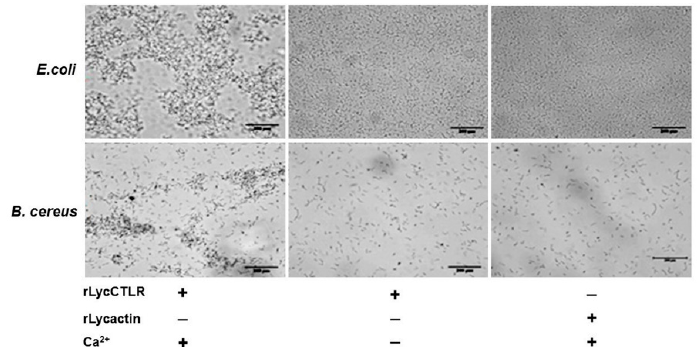
Figure 6. Bacterial agglutination caused by recombinant LycCTLR protein. For bacterial